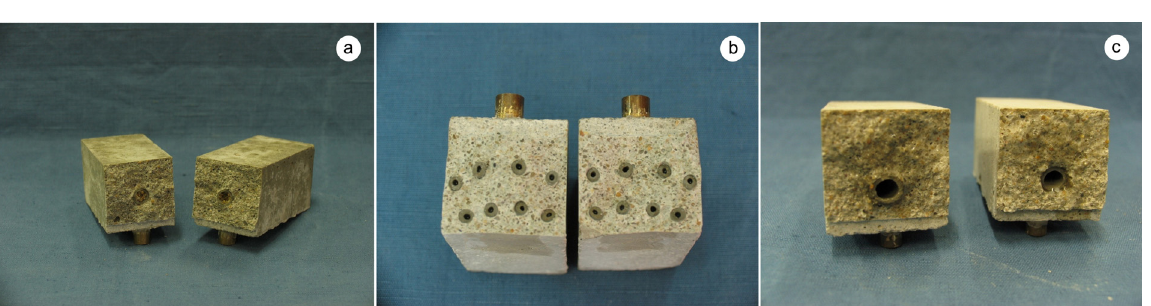
Figure 3. Mortar prisms used for the evaluation of the effectiveness of the proposed self-healing system at the end of 3-point-bending tests: ( a ) sample containing one big hollow tube filled with sand grains (MI series); ( b ) sample with 4 bucatini in the lower portion and 4 additional bucatini in a central position (BU series); ( c ) sample with only 1 maccherone (MS series).